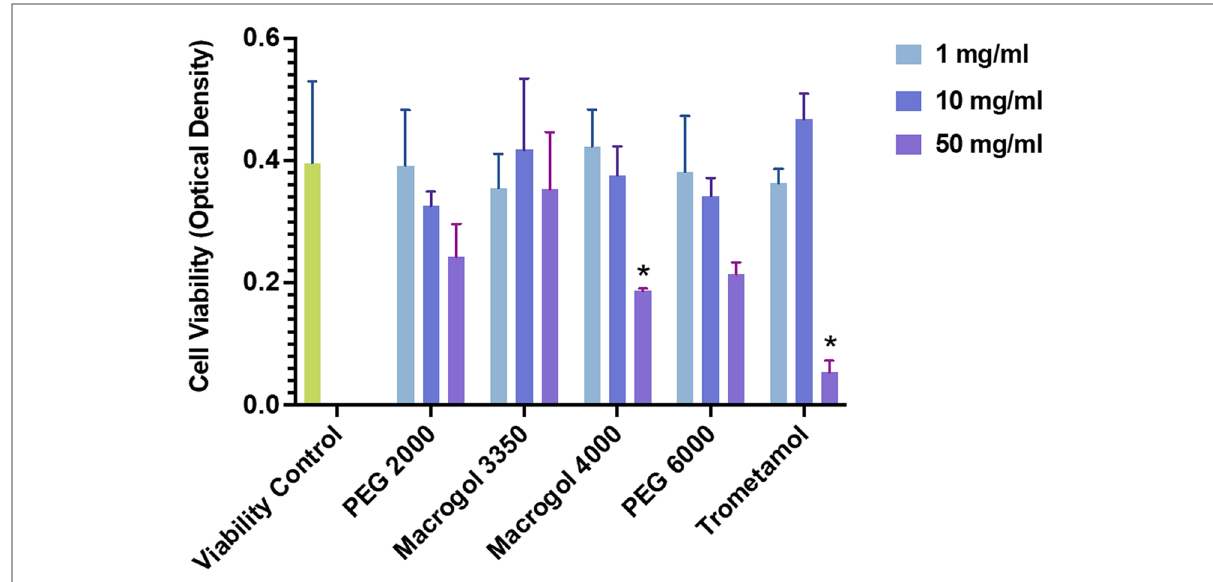
FIGURE 1 Viability of LAD2 MCs after 1 h of incubation with polyethylene glycol/macrogol (molecular weights of 2,000, 3,350, 4,000, 6,000) and trometamol at different concentrations (1, 10, 50 mg/ml), expressed in absorbance units (as measured using the WST-1 assay protocol). Statistically signi fi cant differences ( p <0.05) are marked with asterisks.